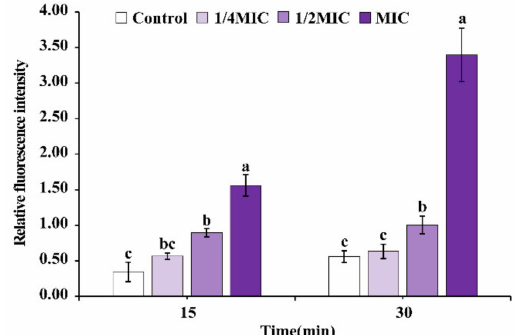
Figure 5. Effect of OEO treatment for 15 and 30 min on intracellular reactive oxygen species (ROS) levels in E. faecalis . Different small letters in each time indicate significant ( p < 0.05) statistical differences among treatments.